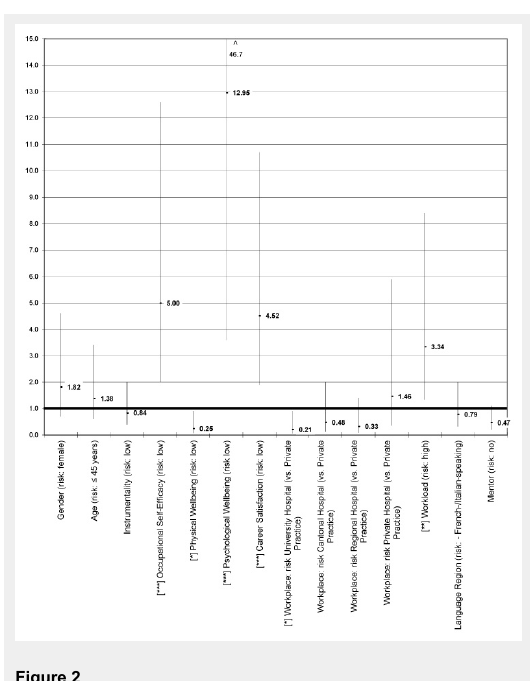
Logistic regression analysis of determinants of radiologists’ professional